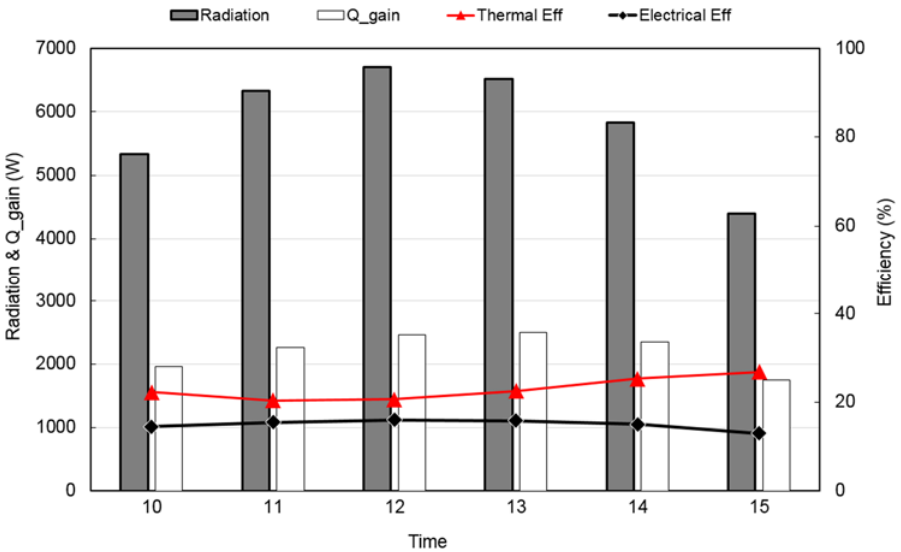
Figure 11. Daily thermal and electrical performance levels of the PVT system.